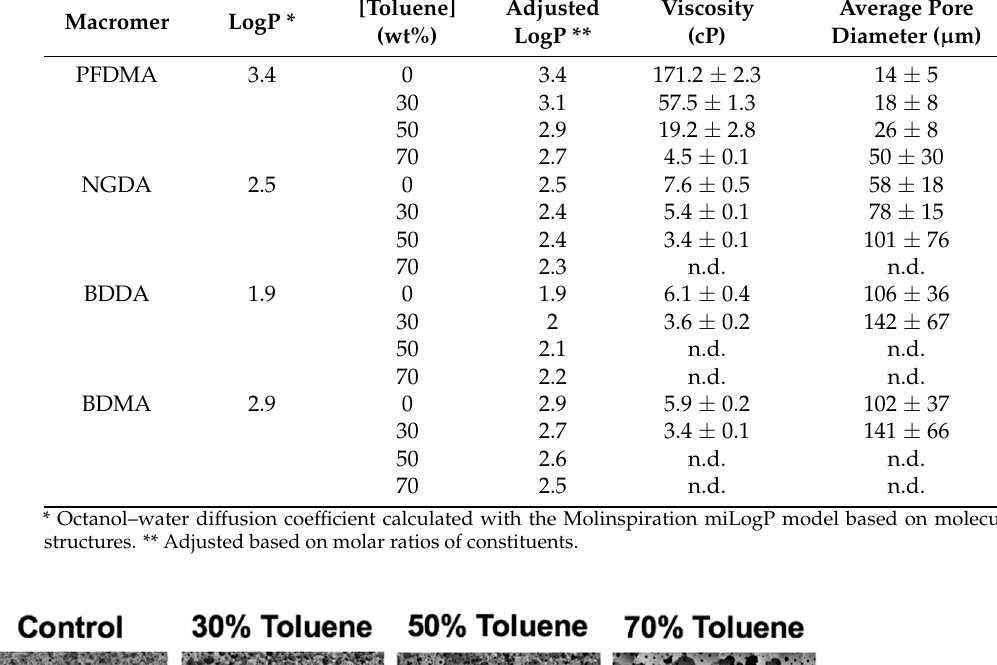
Table 2. Macromer logP *, viscosities at varying concentrations of toluene (logP = 2.4), adjusted logP values **, and associated pore sizes. (Not determined = n.d.). LogP *